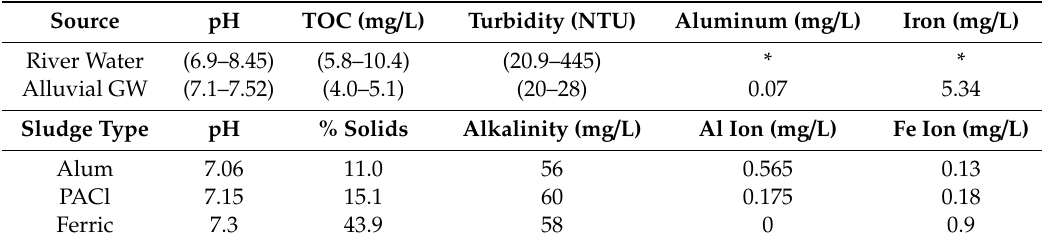
Table 1. Characteristics of incoming